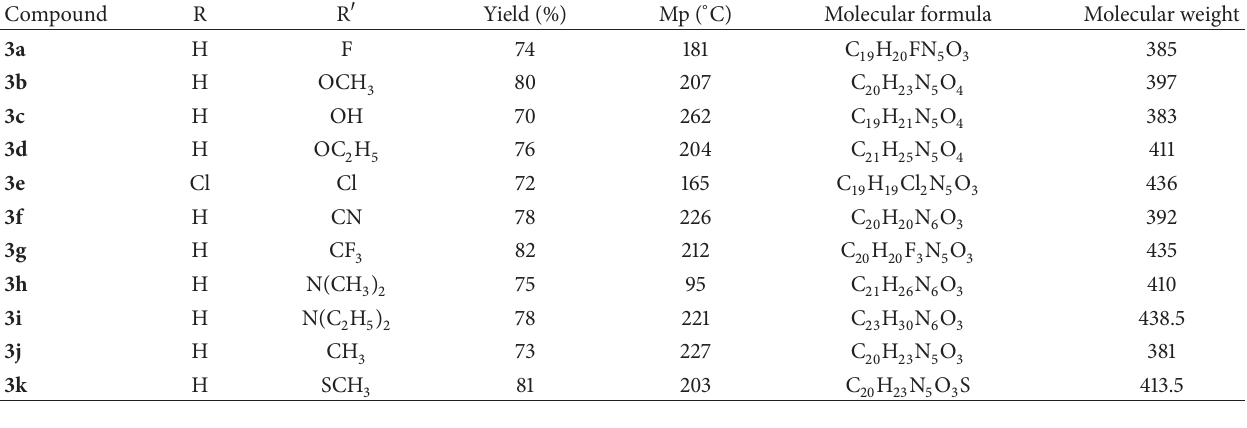
Table 1: Some properties of the compounds ( 3a–k ).